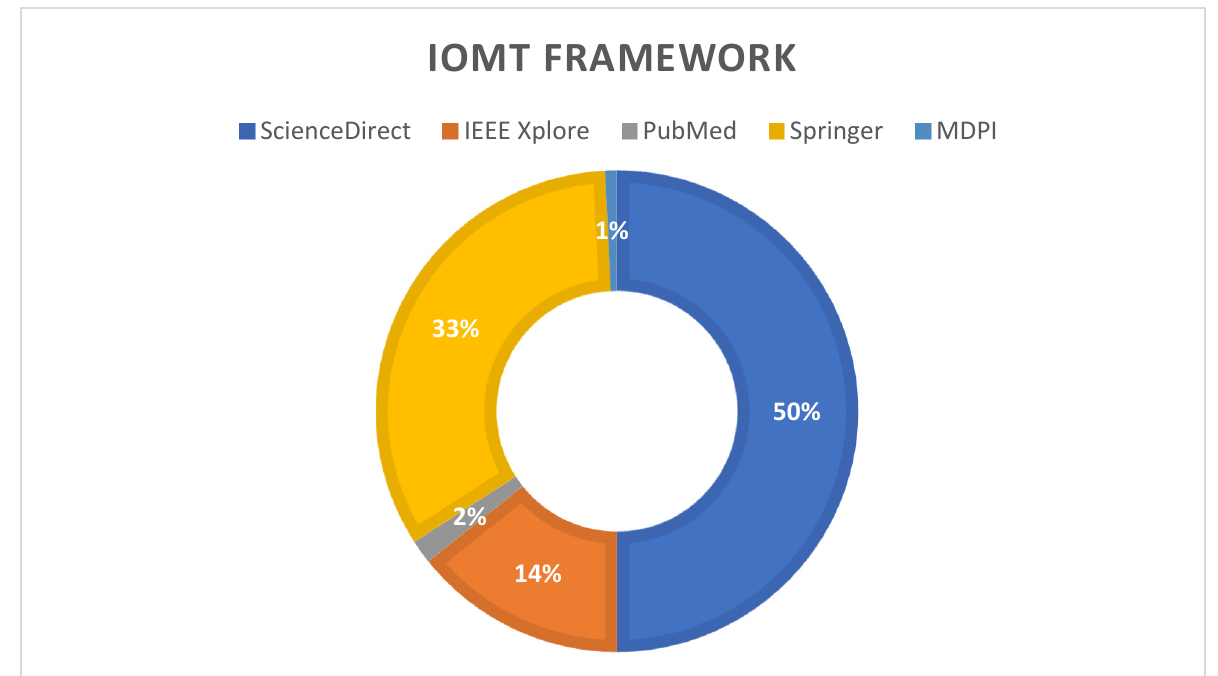
Figure 11. Search result for term IoMT Framework.